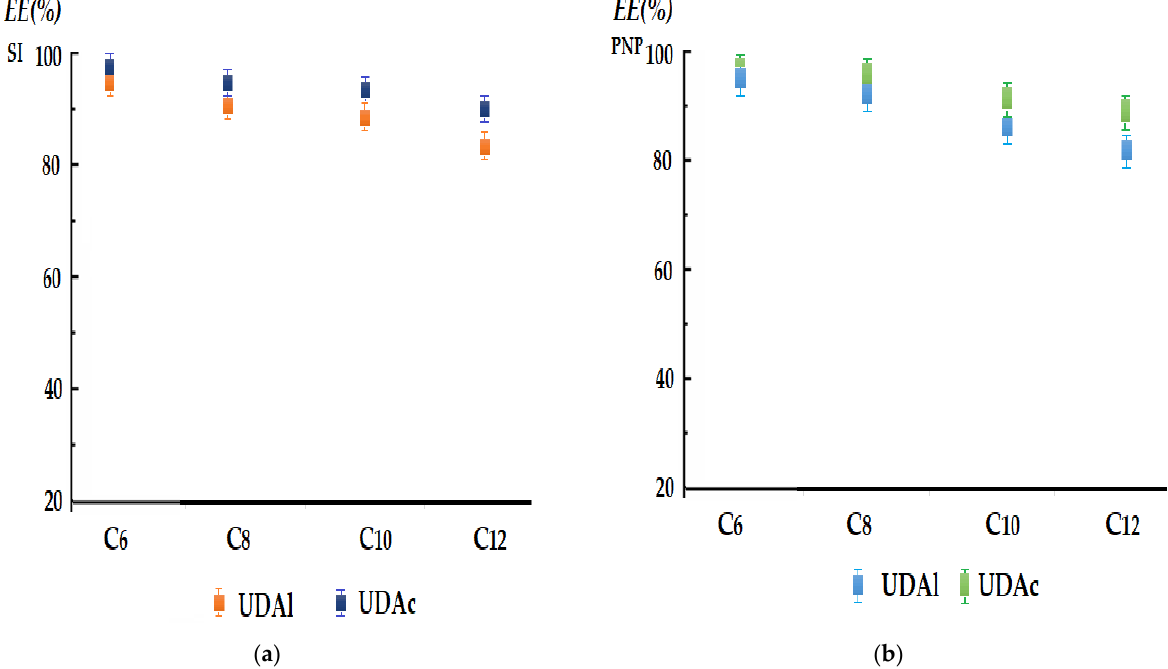
Figure 9. Separation efficiency of silver ions (SI) ( a ) and of p -nitrophenol (PNP) ( b ), depending on the concentration and nature of the membrane phase carriers, 10–undecenoic acid (UDAc) and 10–undecylenyl alcool (UDAl).